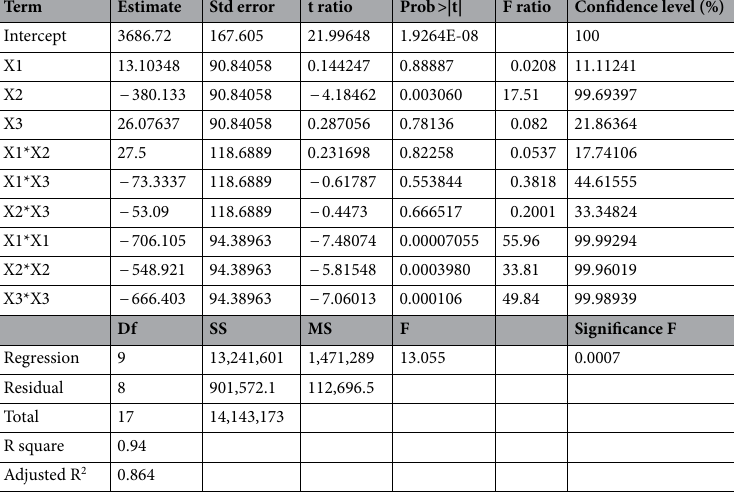
productivity (F-value = 2.71; p -value = 0.178) support the significance and accuracy of the developed model. The significance of each variable on ALP production (i.e., the p- value) are also listed in Table 4; the linear coefficient of (NH 4 ) 2 NO 3 ( X 2 ) and the quadratic effects of molasses ( X 1 × X 1 ), (NH 4 ) 2 NO 3 ( X 2 × X 2 ), and KCl ( X 3 × X 3 ) had significant effects on ALP productivity (with corresponding F- and p -values of 17.51, 55.96, 33.81 and 49.84, respectively, and 0.0030, 0.00007, 0.000398 and 0.000106, respectively). On the contrary, the effect of mutual interaction between (NH 4 ) 2 NO 3 and KCl ( X 2 × X 3 ) had F- and p -values of 0.2 and 0.666, respectively, and thus did not significantly contribute to the response. The linear coefficients of molasses ( X 1 ) and KCl ( X 3 ) and the